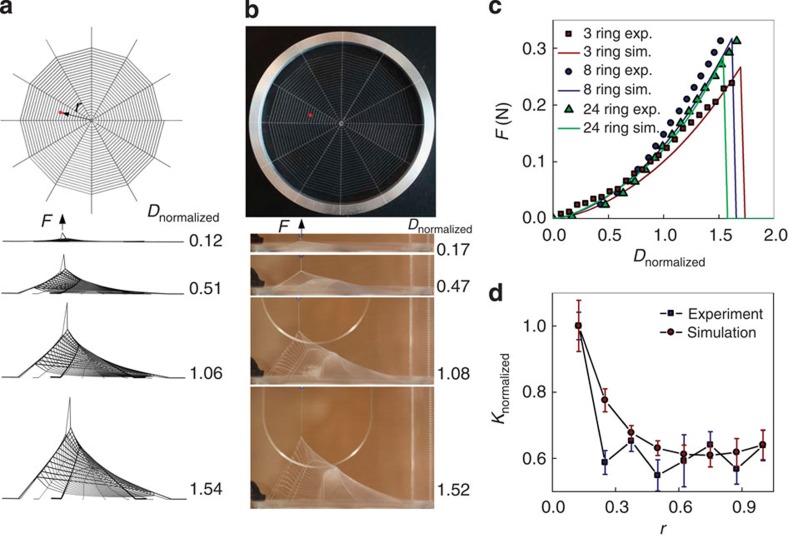
Mechanical response of synthetic webs under point loading.(a) Simulation snapshots of the deformation of a web structure under a point stretching force F applied at the middle of a spiral thread (of 24 rings of spiral threads) with distance r=0.35R from the centre of the web, where R=50.8 mm is the radius of the inner circle of the frame. The periphery of all the radial threads is fixed from displacement. For the sake of simplicity, we use a single rigid rod as a representative shape of prey to deform the web. The displacement of the point under loading (D) is normalized by R (Dnormalized=D/R). (b) Experiment snapshots with the same force and boundary conditions applied to the web made of PDMS via 3D printing with spiral thread diameter of ds=180 μm and radial thread diameter of dr=258 μm, identical to what is used in the numerical model. (c) The simulation (sim.) and experimental (exp.) force–displacement curves of three webs with different number of rings of spiral threads under loading. (d) Mapping the local stiffness (K) of a web (of eight rings) at small deformation both in simulation and experiment. This is obtained by deforming the middle point of several spiral threads and measuring the slope of the force–displacement curve at Dnormalized=0.1, as a function of the distance from the web centre to the loading point. The local stiffness is normalized by that of the innermost spiral thread.